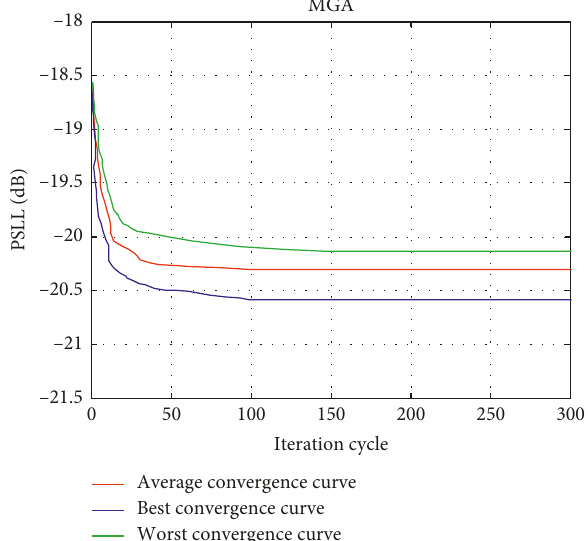
Figure 8: Convergence curve of fitness function. MGA for Example 2 optimization.